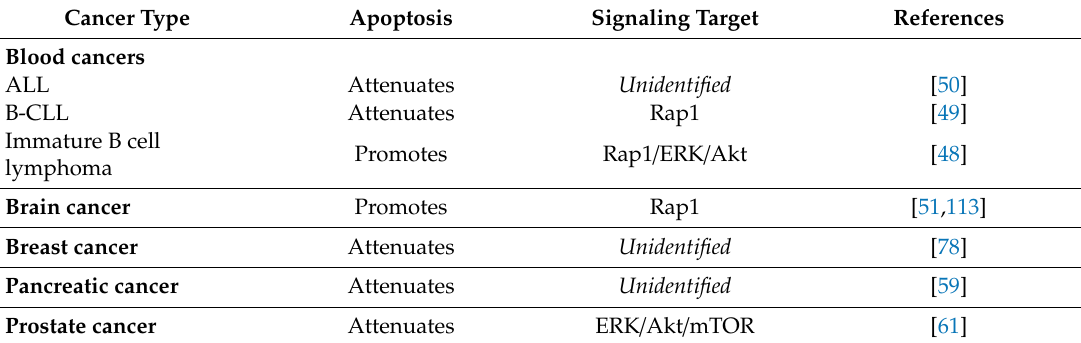
Table 3. Role of Epac in cancer cell apoptosis and its downstream signaling